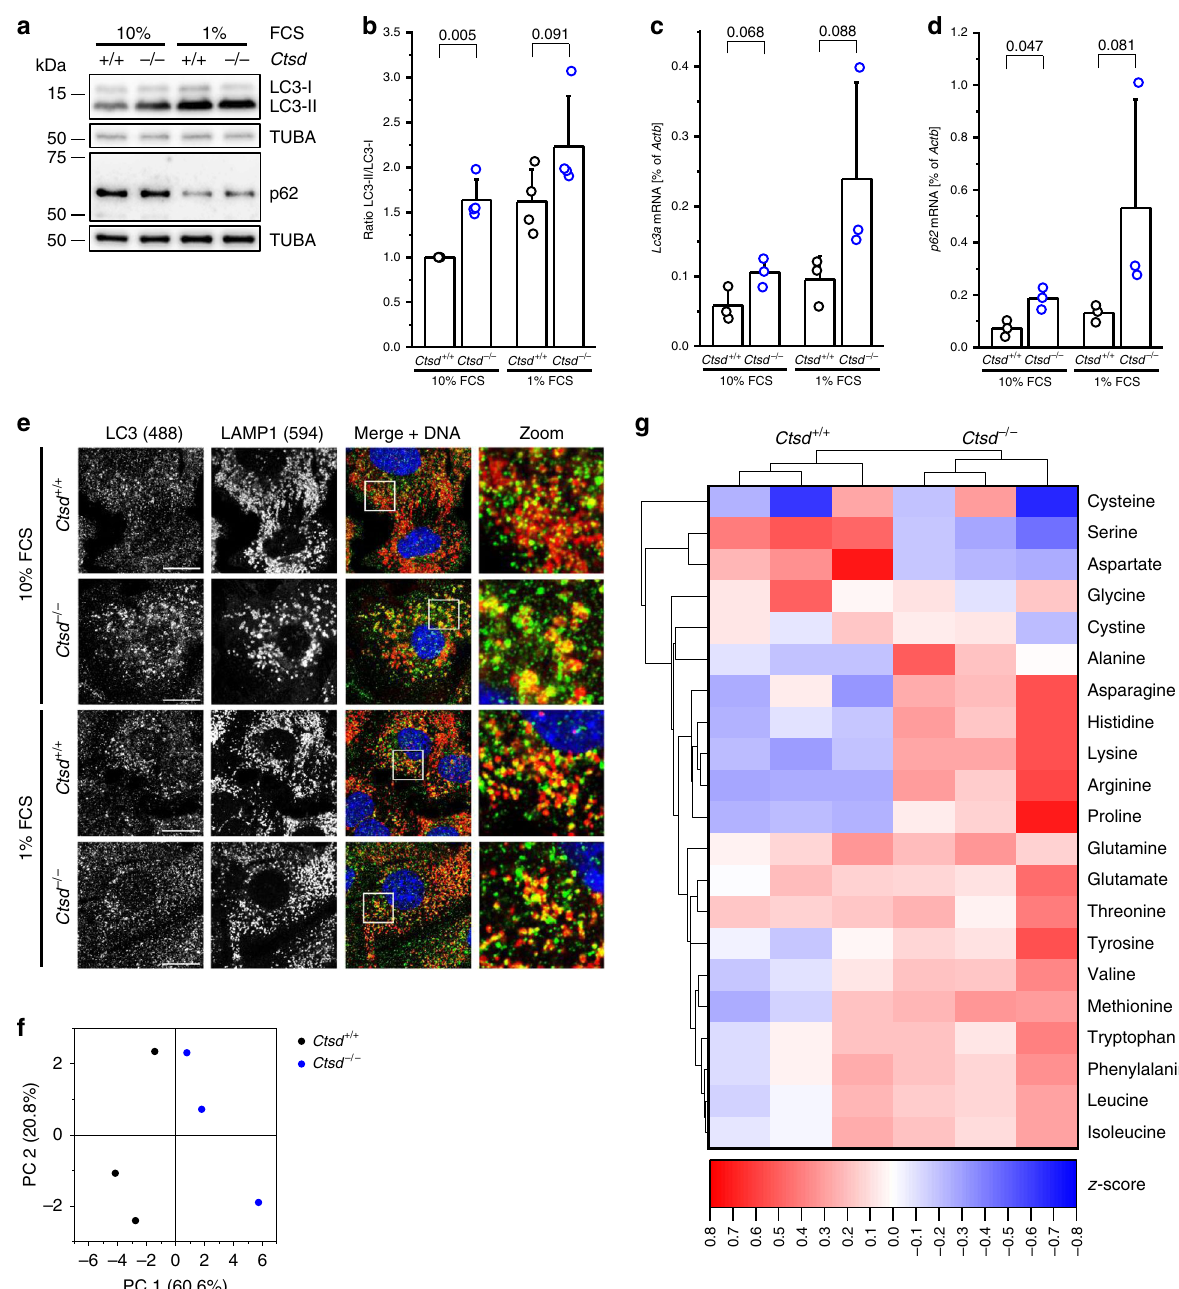
Fig. 5 CTSD de fi ciency induces autophagy in short-term starved tumor cells. a Analysis of LC3-I, LC3-II, and p62 protein levels by Western blot (with TUBA as loading control) in Ctsd + / + and Ctsd − / − PyMT cells cultured for 7 – 10 days in 10% FCS or 1% FCS medium. Representative of 4 independent experiments. b Quanti fi cation of LC3 Western blots as in a , plotted as LC3-II/LC3-I ratio relative to 10% FCS Ctsd + / + ( n = 4 independent experiments; two-sided one-sample and two-sample t -test). Relative Lc3a ( c ) and p62 ( d ) expression determined by RT-PCR in 10% FCS and 1% FCS Ctsd + / + and Ctsd − / − PyMT cells ( n = 3 independent experiments; two-sided two-sample t -test). e Pictures of 10% FCS and 1% FCS Ctsd + / + and Ctsd − / − PyMT cells stained for LC3 (green), LAMP1 (red), and DNA (blue). Zoom shows enlargement of indicated image area in merge + DNA. Bars, 10 μ m. Representative of 3 independent experiments. f Principle component analysis (PCA) of targeted metabolomics data from 1% FCS Ctsd + / + and Ctsd − / − PyMT cells ( n = 3 independent experiments). g Clustering analysis of the relative abundance of all 20 canonical amino acids and cystine in 1% FCS Ctsd + / + and Ctsd − / − PyMT cells shown as heatmap ( n = 3 independent experiments). Bar charts show all data points with mean + SD and p- value. Source data are provided as a Source Data fi LC3-II/LC3-I ratio as well as an induction of Lc3a mRNA is induced and also successfully executed in Ctsd − / − cells. As a expression when cultured in presence of 10% FCS (Fig. 5a – c). further indicator for that, protein levels of the autophagy cargo These differences did not reach signi fi cance in FCS-starved receptor p62 were reduced upon FCS starvation in Ctsd + / + and medium, most likely because of the induction of autophagy in Ctsd − / − cells, probably due to p62 degradation in the autolyso- some (Fig. 5a). Of note, the Ctsd genotype did not affect p62 Ctsd + / + control cells. Together these data suggest that autophagy